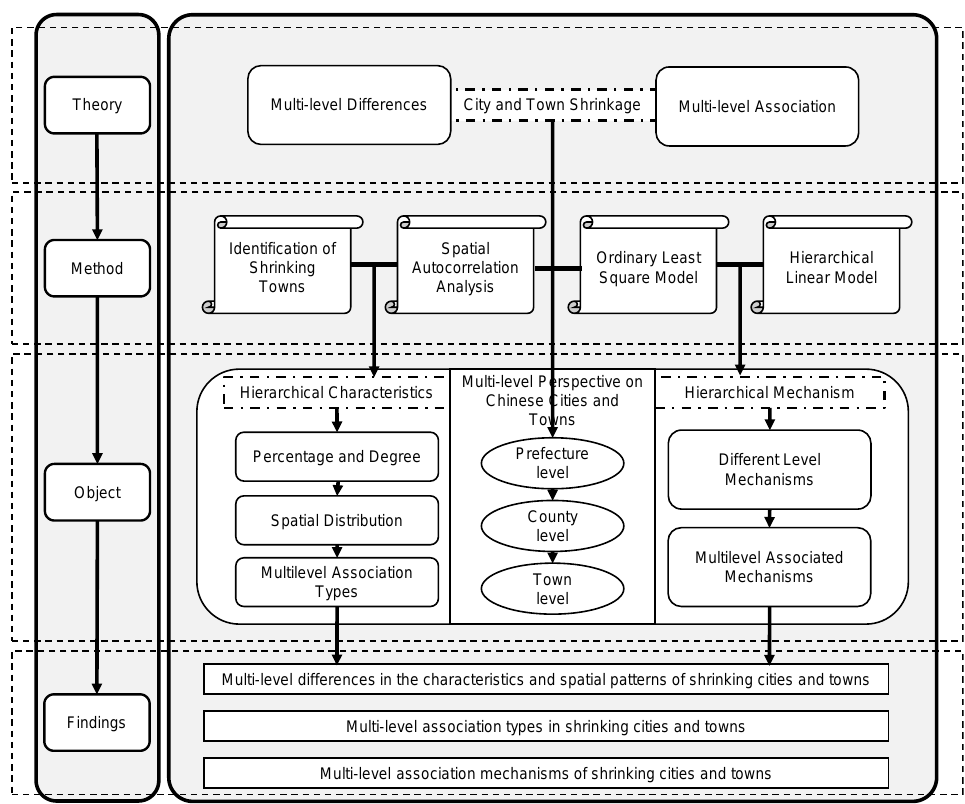
Figure 2. A multi-level framework for understanding the shrinkage of cities and towns.